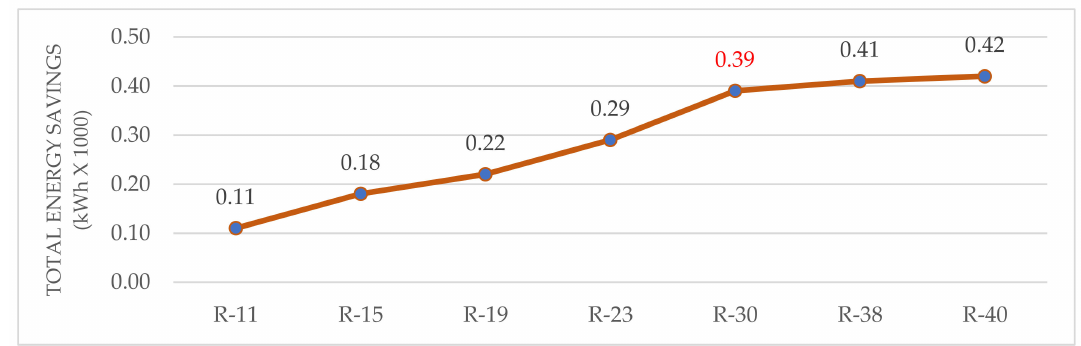
Figure 12. The impact of additional roofing insulation on the total annual electricity consumption of the building.